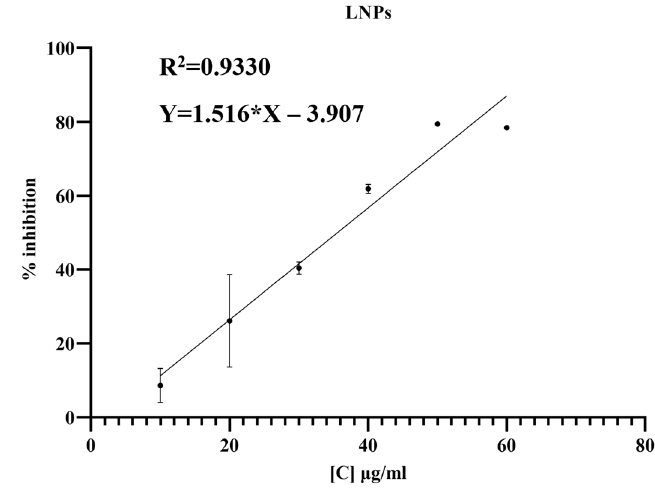
Figure 2. MTT assay to calculate IC 50 for synthesized LNP.